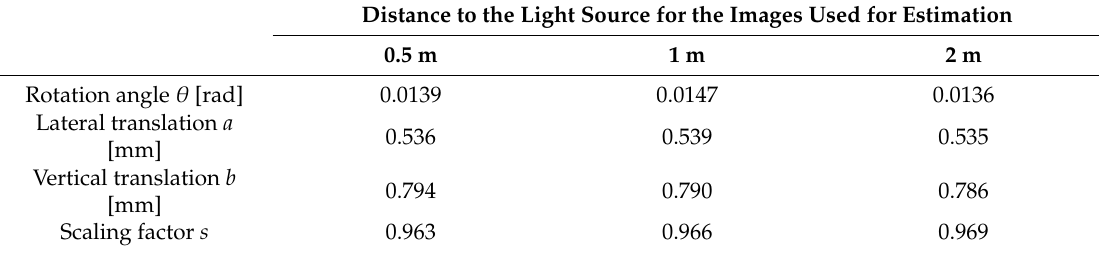
Table 3. Estimated parameters for mapping thermal images to color